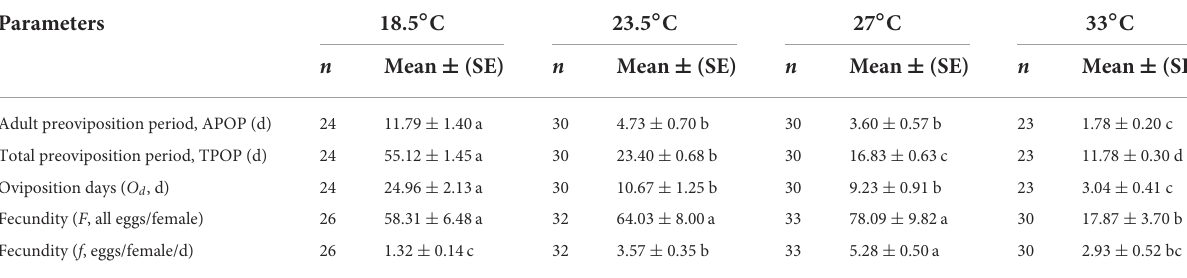
TABLE 2 Preoviposition period, oviposition period, and fecundity of Orius strigicollis preying on Frankliniella occidentalis at different temperatures. Parameters